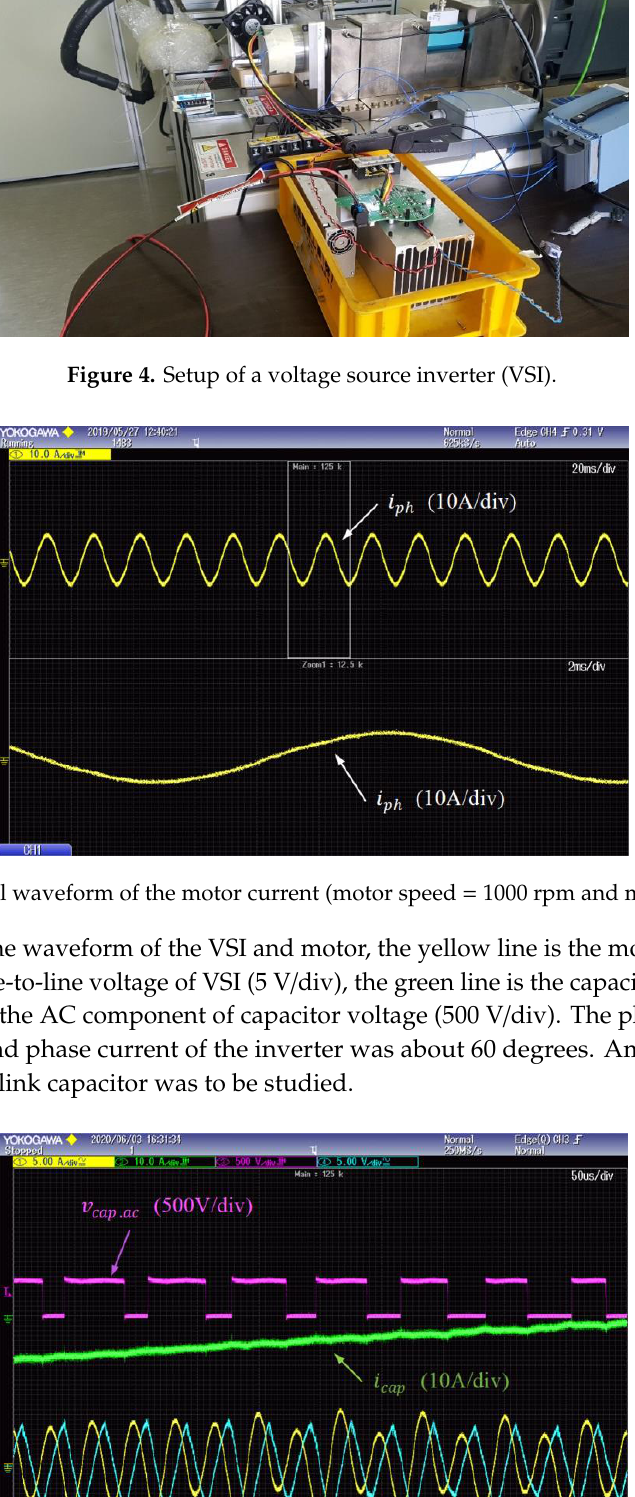
Figure 6. Experimental waveforms of the line-to-line voltage of VSI, motor current, capacitor current